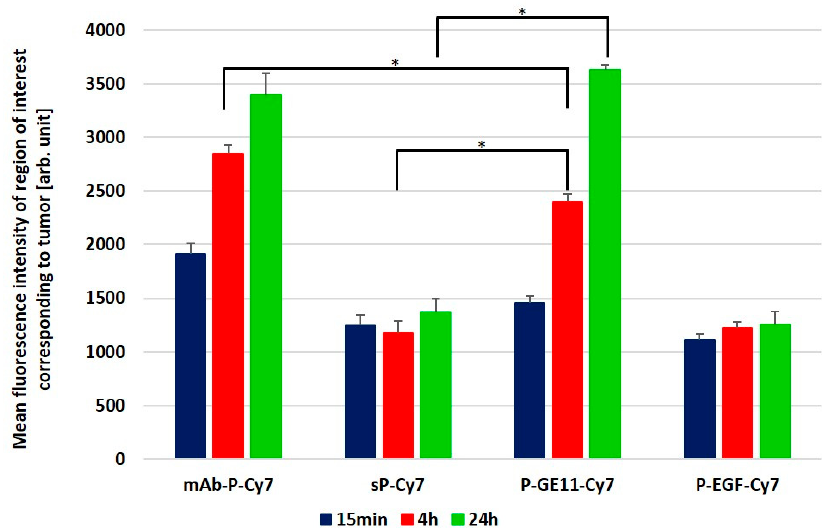
Figure 6. In vivo tumor accumulation of polymer probes containing Erbitux, GE-11, human EGF or no targeting moiety ( mAb-P-Cy7 , P-GE11-Cy7 , P-EGF-Cy7 and sP-Cy7 ). The MFI was determined by the In-Vivo Xtreme In Vivo Imaging System. The data are presented as the mean ± SEM of duplicates of two independent experiments. * P values < 0.05. Number of mice n = 8.